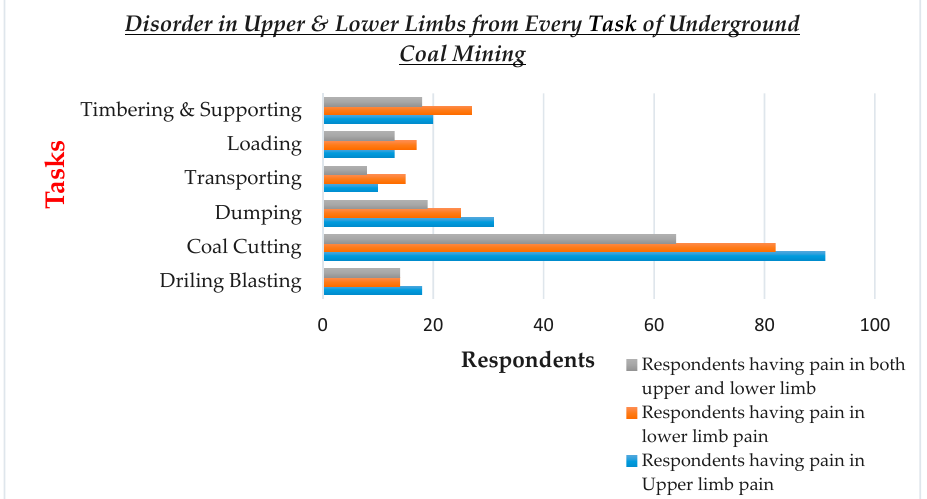
Figure 1. Comparison of pain reported in upper, lower limbs, and then both limbs.